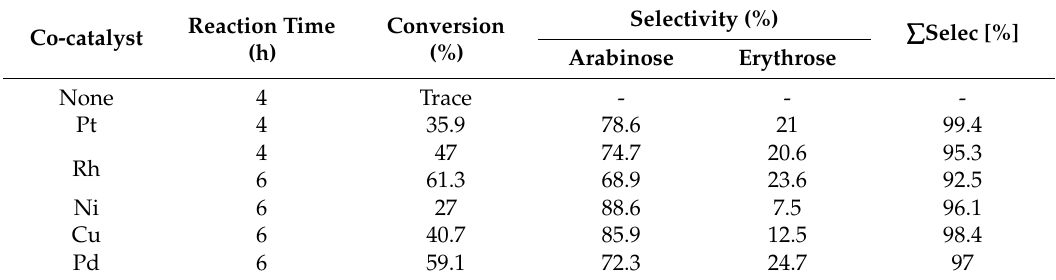
Table 5. Direct conversion of glucose to arabinose and erythrose using TiO 2 -R-loaded catalysts developed by Chong et al.